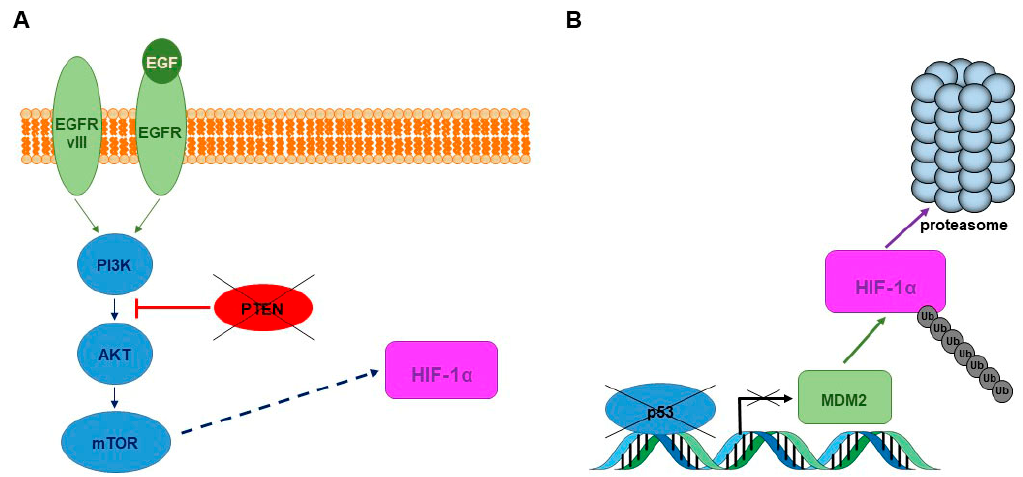
Figure 2. Genetic alterations that lead to HIF activation in GBM. ( A ) EGFR gene amplification and/or overexpression is frequent in GBM. The most common EGFR gene mutation (EGFRvIII) consists in the deletion of exons 2–7, resulting in a constitutively active and ligand independent receptor. Initiation of EGFR/EGFRvIII signaling by ligand binding, gene amplification, or mutation results in activation of the PI3K/AKT/mTOR pathway with the subsequent up-regulation of HIF-1 α . PTEN gene deletion is common in GBM. PTEN protein is the main inhibitor of the PI3K/AKT signaling pathway, as such loss of PTEN function leads to increased HIF-1 α via the PI3K/AKT/mTOR pathway; ( B ) It has been proposed that p53 may lead to inhibition of HIF activity in hypoxia by promoting MDM2-mediated ubiquitination and degradation of HIF-1 α . Therefore, the loss of the p53 gene, which is common in GBM, will lead to HIF-1 α stabilization.